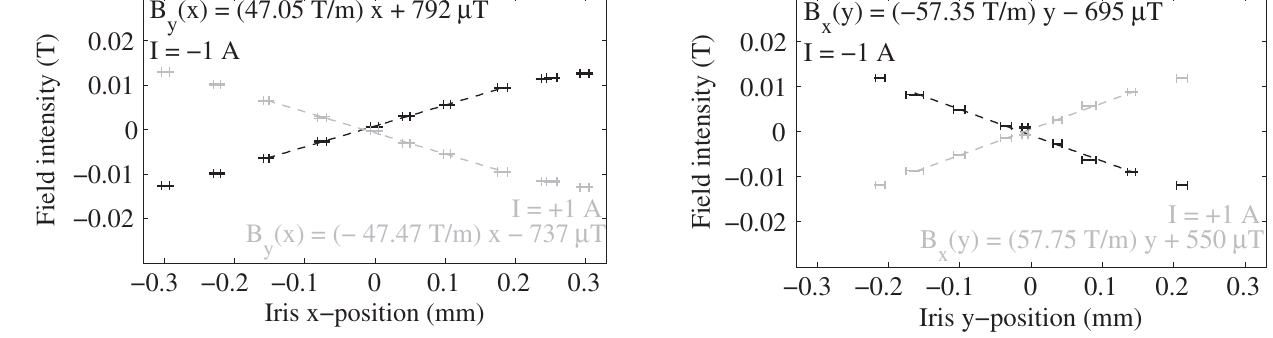
FIG. 12. Y-axis transverse field profile measured with a 0.02 mm electron beam probe. Error bars and regression lines show the field across the center of the gap. 54 . 3 T = m gradients at 1 A are expected from FEM simulations.